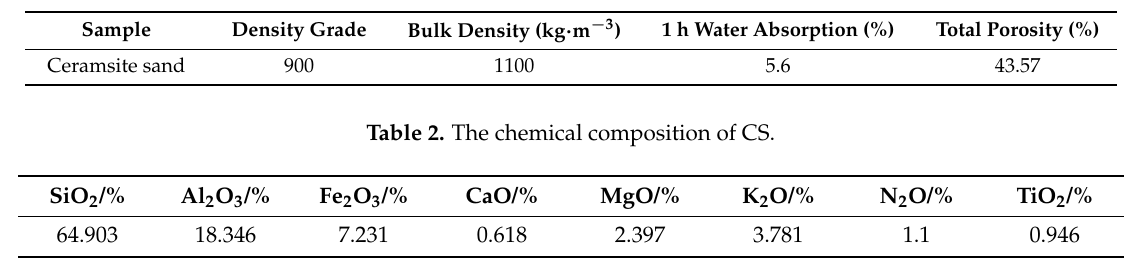
Table 1. The physical characteristics of CS.